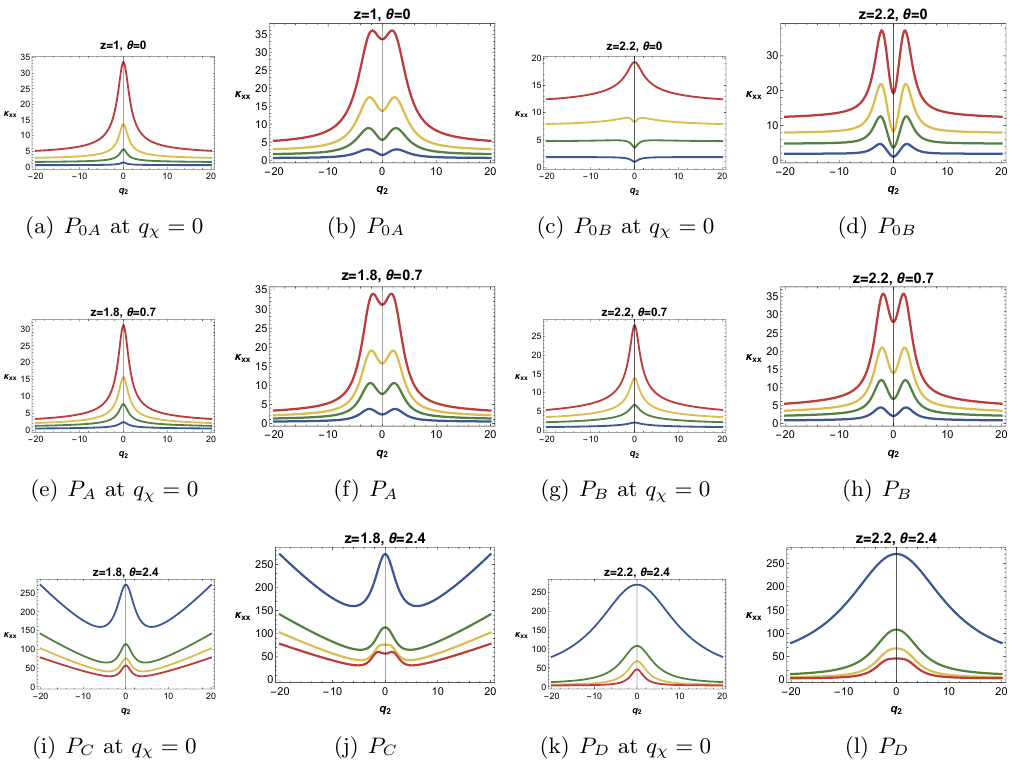
Figure 22 . Temperature evolution for (cid:20) xx ( q 2 ) for di(cid:11)erent ( z; (cid:18) ). Each curves corresponds to T = 0 : 04 ; 0 : 1 ; 0 : 160 : 24 for blue, green, yellow, and red respectively. In all (cid:12)gure, q (cid:31) = 5.